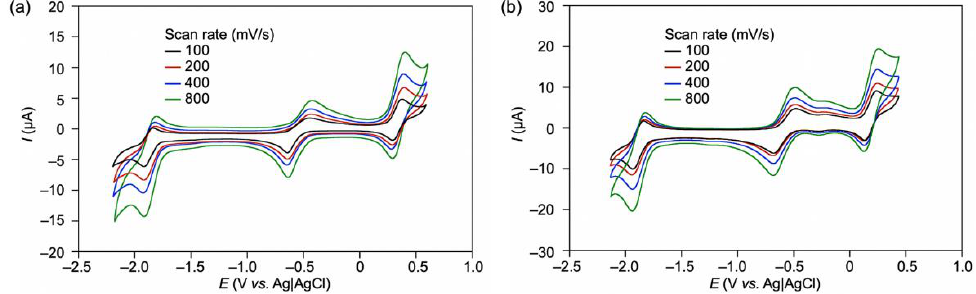
Figure 2. UV-vis spectral changes of CoCor upon addition of pyridine (blue line: 0% v/v , red line: